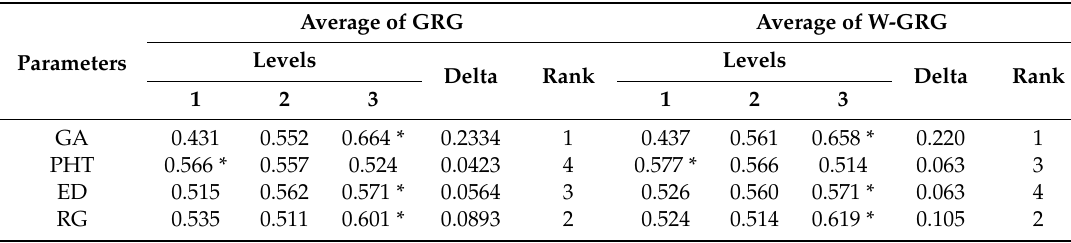
Table 8. Response table for average GRG and W-GRG.